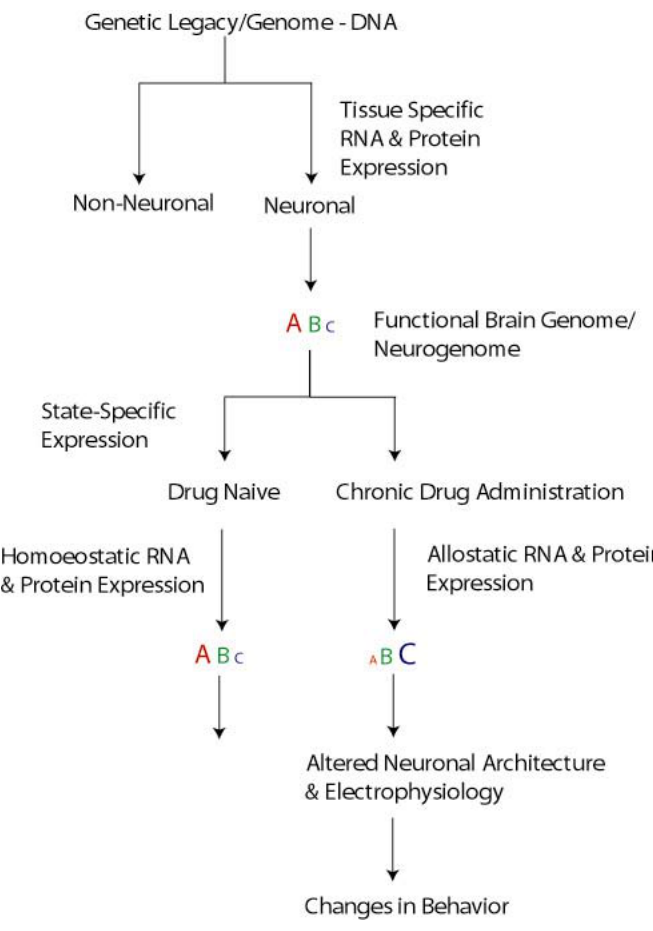
FIGURE 1. Functional genomics and drug abuse. Chronic abuse of a drug can perturb the normal, homeostatic expression of genes. The new, allostatic pattern of gene expression may underlie the changes in behavior associated with drug